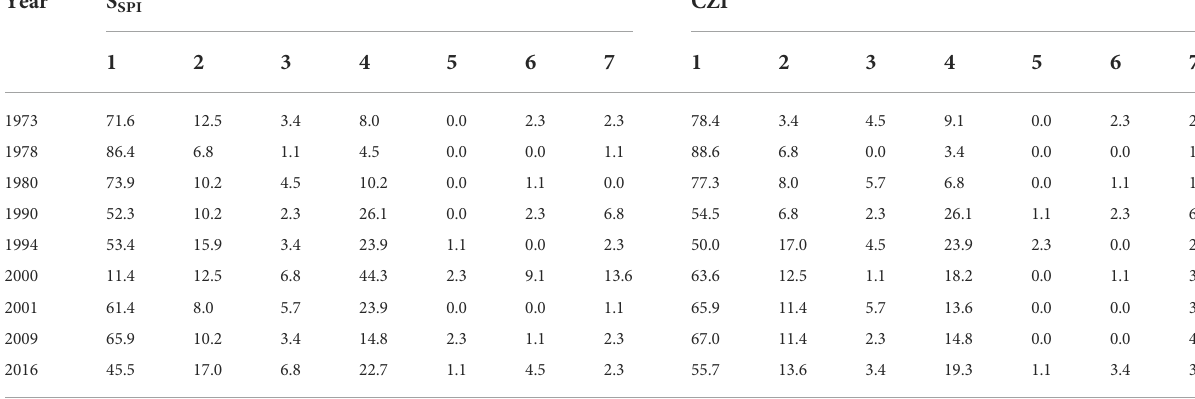
TABLE 2 Comparison of station ratio in extreme fl ood years in fl ood season (%). S SPI CZI